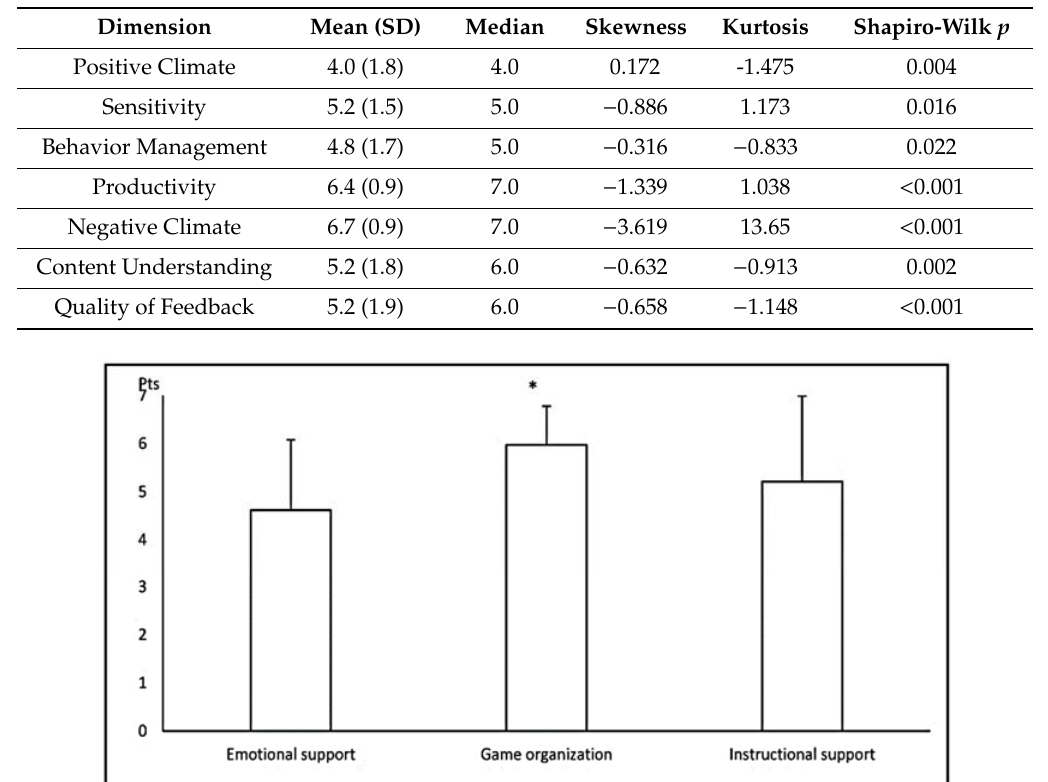
Figure 2. Mean ( ± SD) ratings of the quality of referee–player interactions in individual domains observed in Soccer (n = 25) referees. * significantly ( p < 0.05) higher than in the two other domains (Friedman’s ANOVA followed by Wilcoxon’s signed ranks test).